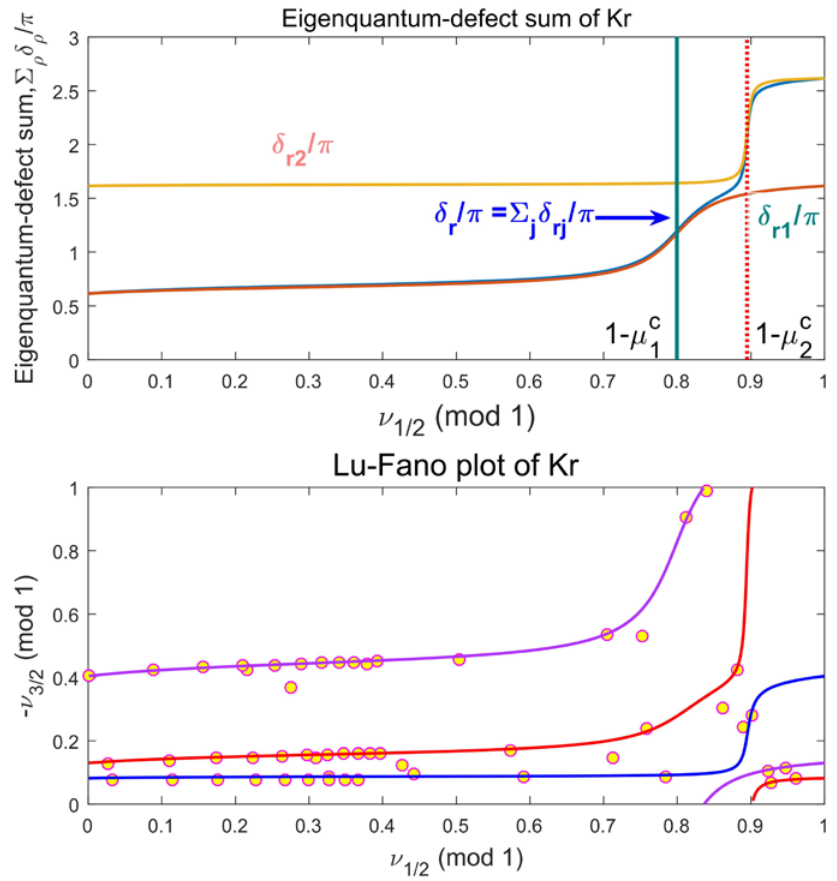
Figure 10. Eigenquantum defects and their sum and the Lu-Fano plot for the J = 1 states of krypton at the lowest ionization thresholds 2 P o